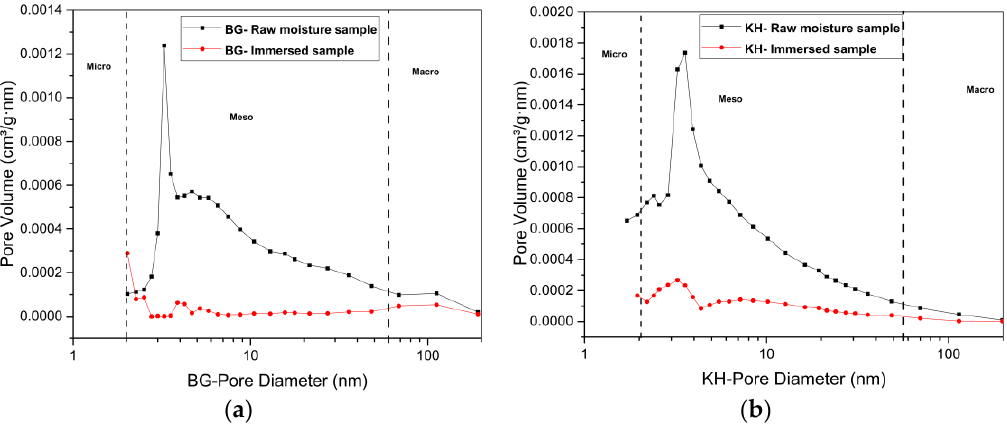
Figure 5. Pore size distribution defined by differential pore volume by low pressure gas N 2 adsorption analysis. ( a ) BG sample; ( b ) KH sample.